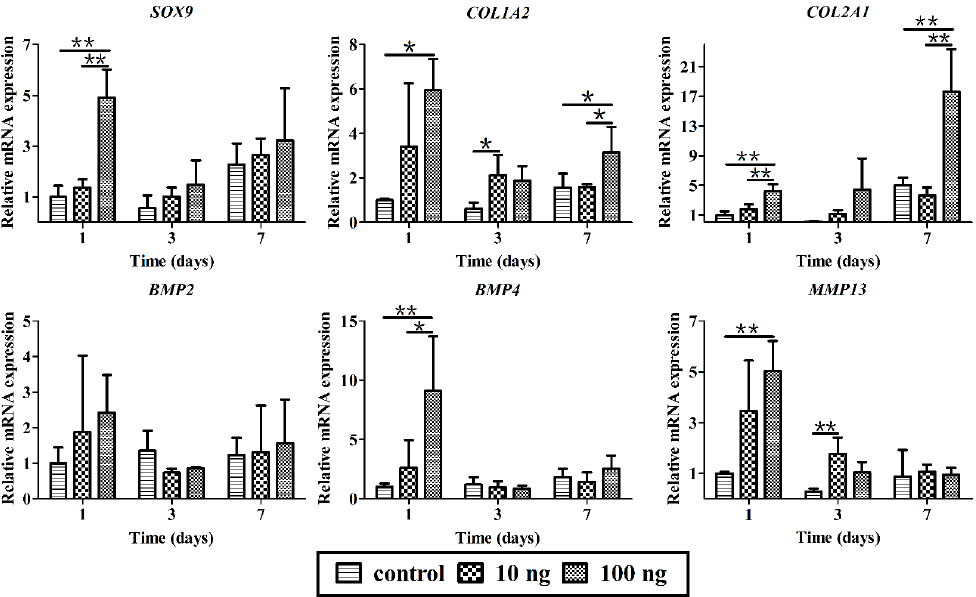
Figure 6. Effect of BMP3 on gene expression of BMSCs in vitro . 10 ng means 10 ng/mL; 100 ng means 100 ng/mL BMP3 in the culture media; control, without BMP3. Mean ˘ SD, n = 3; * p < 0.05,